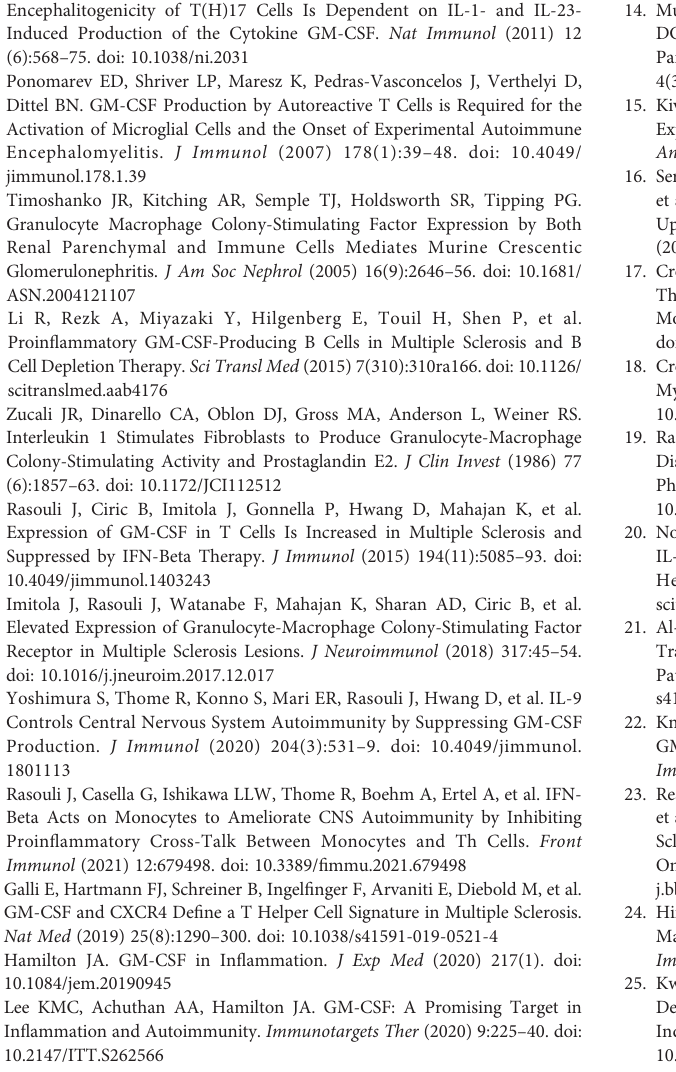
sorted. ThGM and GM-CSF + Th1 cells were enriched based on their GM-CSF expression using GM-CSF secretion assay kit. Supplementary Figure 2 | Sorted human ThGM cells do not express Th1, Th2, andTh9markers.T M ,ThGM,andTh1cellswereFACS-sorted,activatedwithPMA/ Ionomycin/GolgiPlug and analyzed by fl ow cytometry. Representative fl ow cytometry dot plots showing GM-CSF, IFN- g , IL-4, IL-5, IL-9, IL-13, and GATA3 expression by T M , ThGM and Th1 cells. Supplementary Table 1 | Mouse fl ow cytometry antibodies. Supplementary Table 2 | Human fl ow cytometry antibodies. Supplementary Table 3 | Sequences of sgRNAs and detection